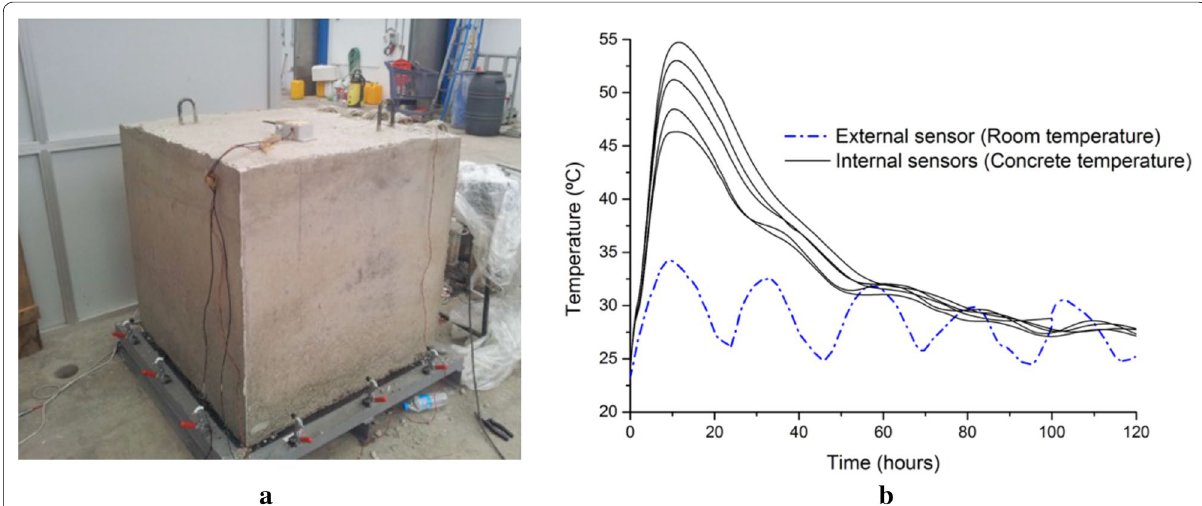
Fig. 3 a Cast concrete cube used in the calibration process and b experimental measurements in some temperature sensors inside the concrete cube, and the room